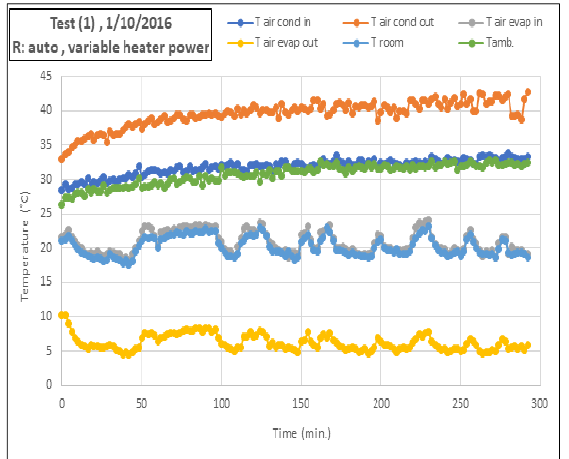
Fig. 10a. Air temperature with time for test 1.